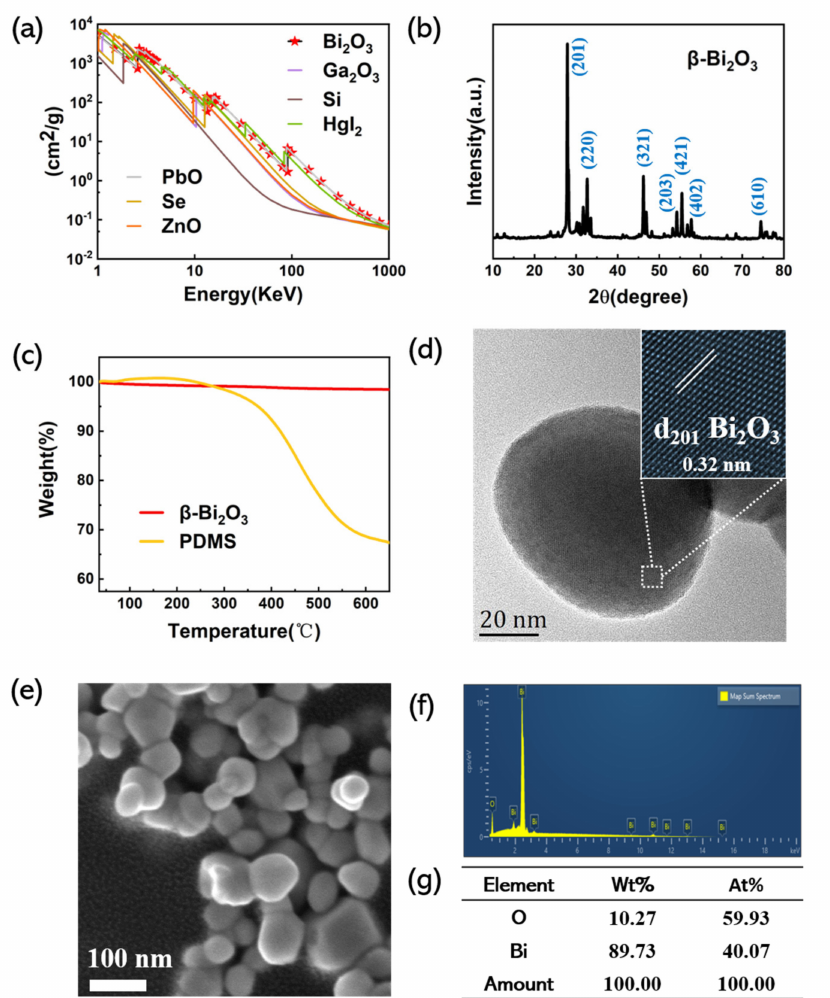
Figure 2. ( a ) Absorption coefficients values of Bi 2 O 3 , Ga 2 O 3 , Si, HgI 2 , PbO, Se, and ZnO; ( b ) the XRD pattern; ( c ) the TGA of Bi 2 O 3 nanoparticles and PDMS; ( d ) a TEM image of Bi 2 O 3 nanoparticles, inset is high-resolution TEM image and shows the d-spacing of 0.32 nm correlating to the (201) plane; ( e ) a SEM image of Bi 2 O 3 nanoparticles; ( f , g ) the EDS of Bi 2 O 3